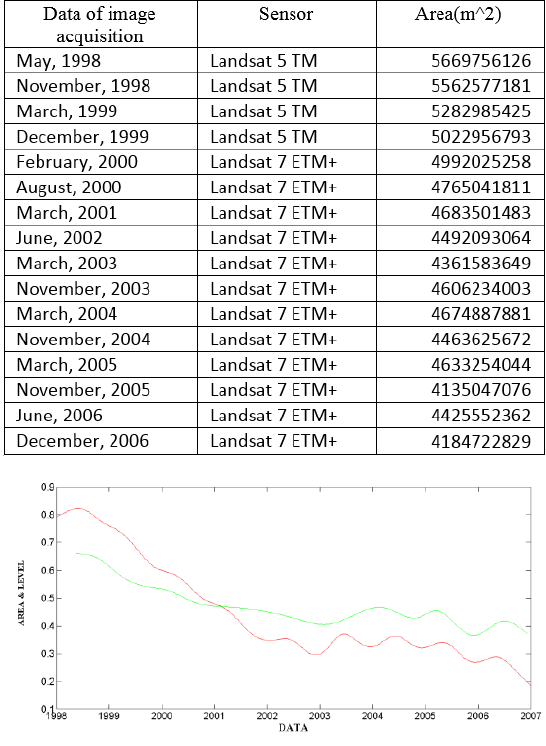
Fig. 4. The computed Lake area fluctuation (Green), water level fluctuation (Read).